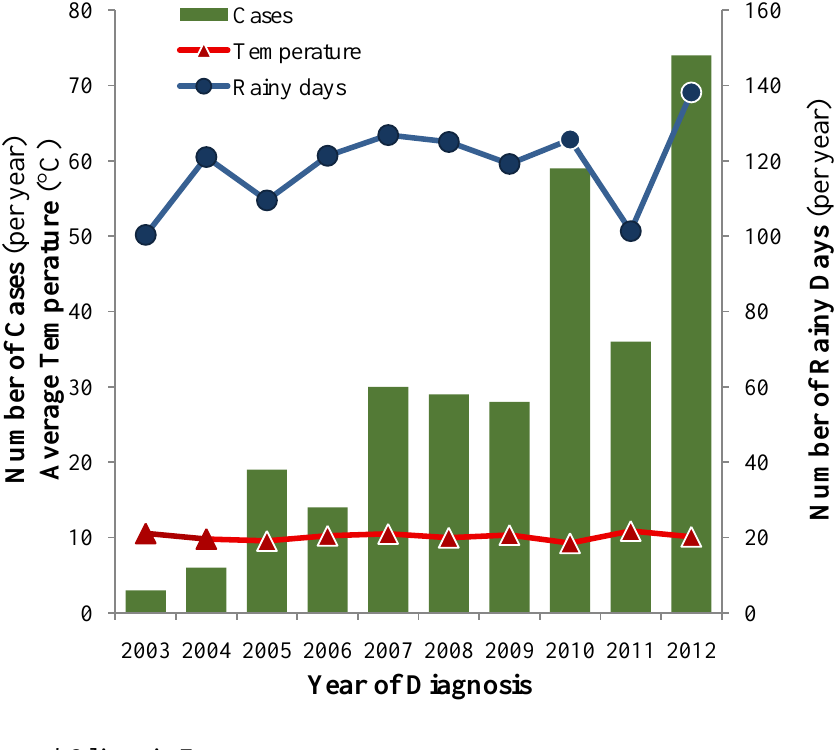
Figure 5. Annual number of cases of canine leptospirosis diagnosed at the University of Bern from 2003–2012 and association with country-wide average annual temperature and number of rainy